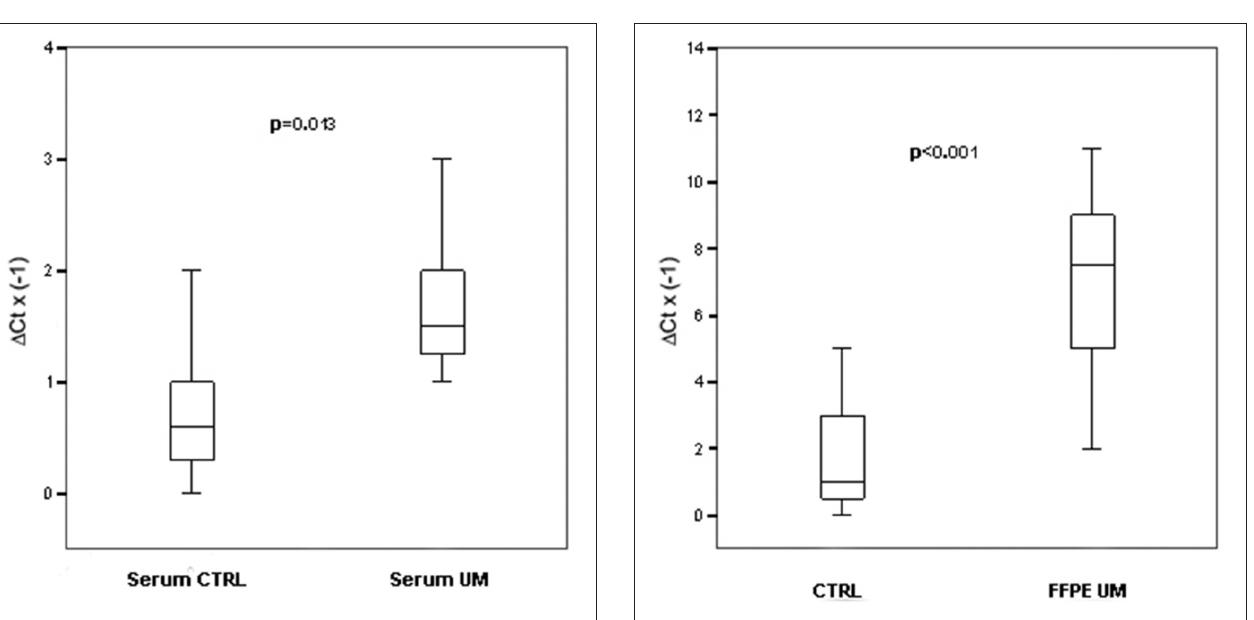
FIGURE 2 | MiRNAs expression. In FFPE UM specimens. Box plots representing the expression of miRNA-146a analyzed by single TaqMan assay on paraffin-embedded UM compared to healthy choroidal melanocytes. y-axis represents the − 1 Ct of miRNAs in melanoma patients respect to normal controls. Statistical significance was evaluated by the Wilcoxon rank sum test ( p <